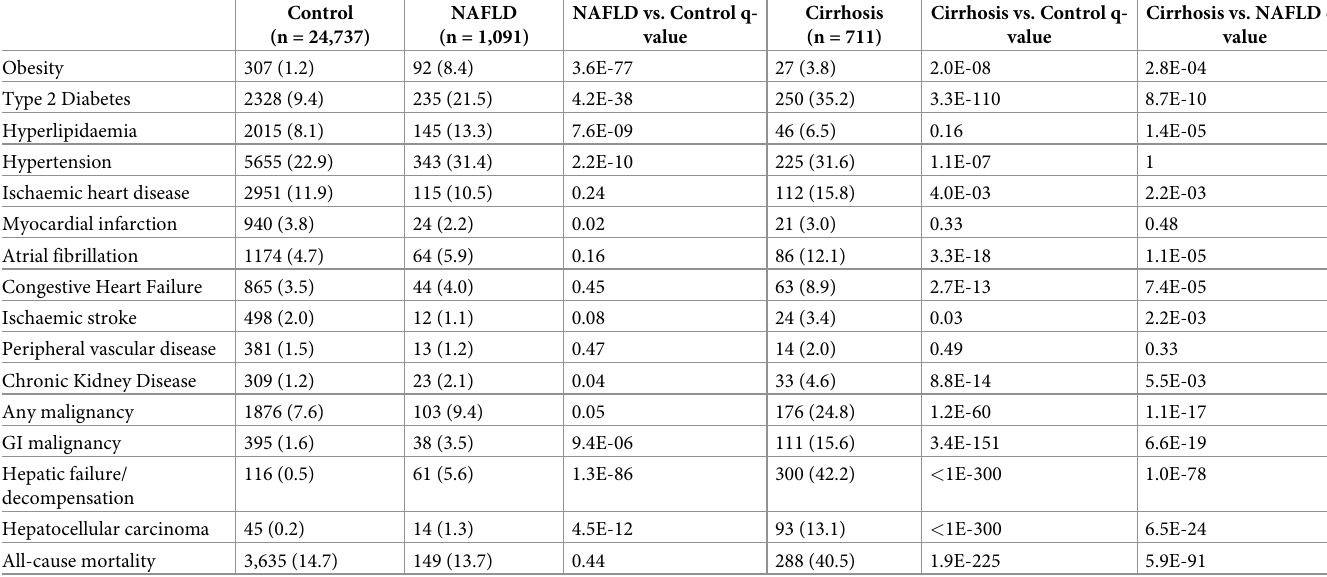
Table 2. Cardiovascular disease burden and liver-related events across the NAFLD